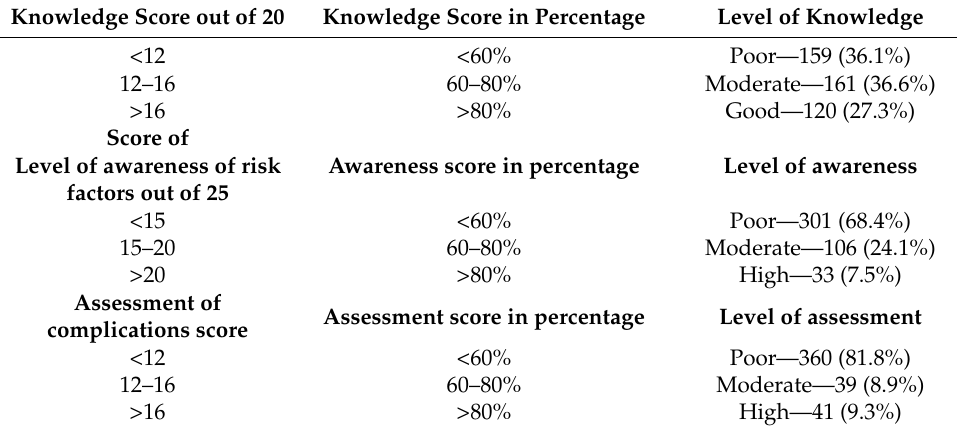
Table 3. Level of knowledge about chronic kidney disease, awareness of the risk factors, and awareness of the complications associated with CKD.